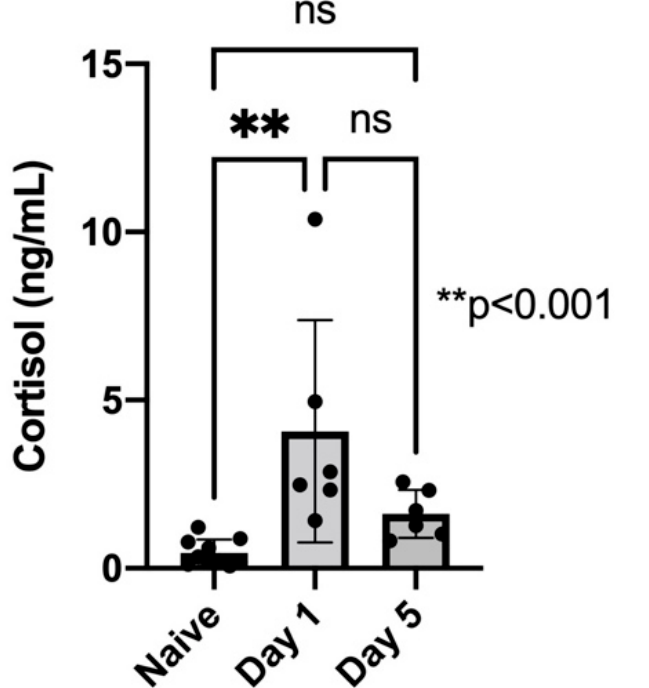
Figure 4. Cortisol levels of naïve (unacclimated) mice (N = 10) compared to cortisol levels of acclimated mice (N = 6) on day 1 and day 5 of the acclimation protocol. Significant increase ( p = 0.003, one ‐ way ANOVA) in cortisol levels after day 1 of acclimation, compared to naïve mice. After day 5 of acclimation the cortisol levels were no longer significantly different from baseline (naïve) levels.